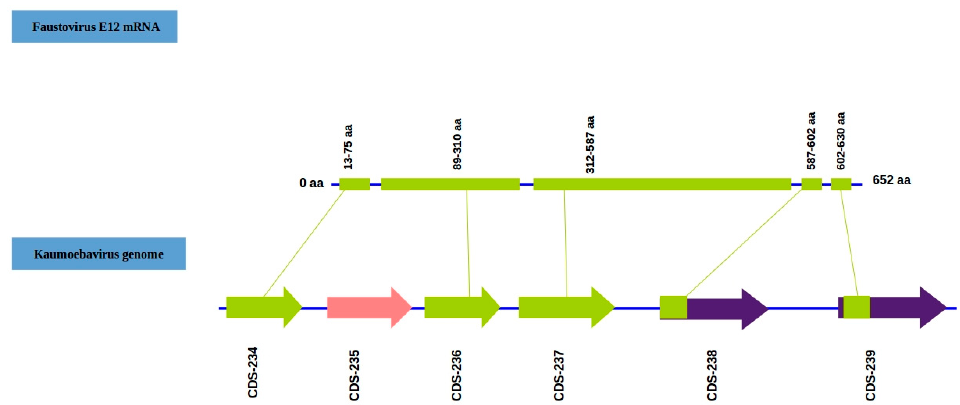
Figure 5. Overview of the genomic region in Kaumoebavirus that encodes the major capsid protein and the corresponding match in the Faustovirus E12 mRNA. The sequences coding for the major capsid protein are shown in green. A conserved nuclease found in the capsid region of both Faustoviruses and Kaumoebavirus is colored pink. Regions of Kaumoebavirus annotated as ORFs having a partial similarity with Faustovirus E12 mRNA are colored purple; only the parts with high similarity to Faustovirus E12 mRNA are colored green.